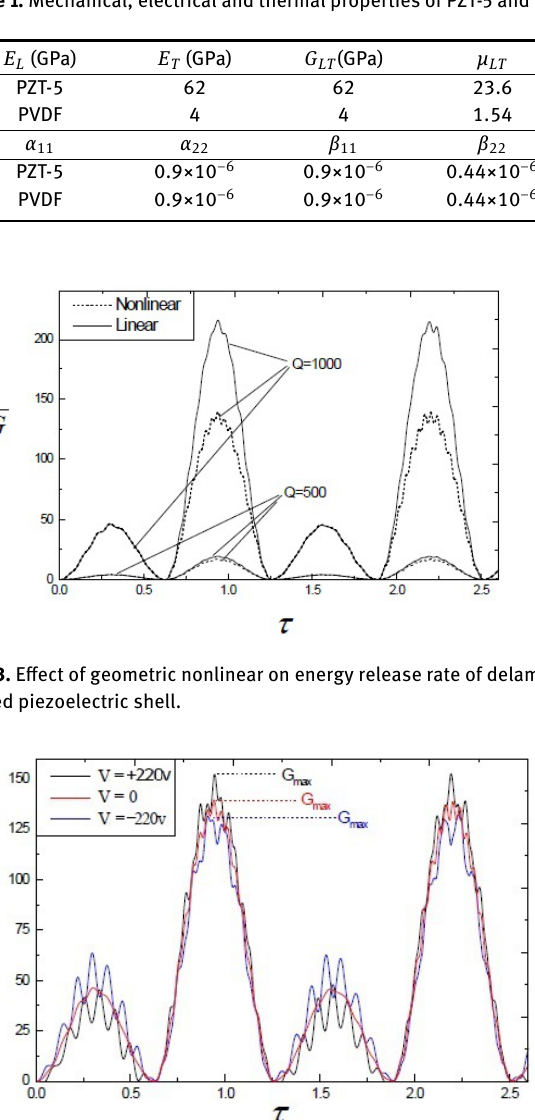
Table 1. Mechanical, electrical and thermal properties of PZT-5 and PVDF.